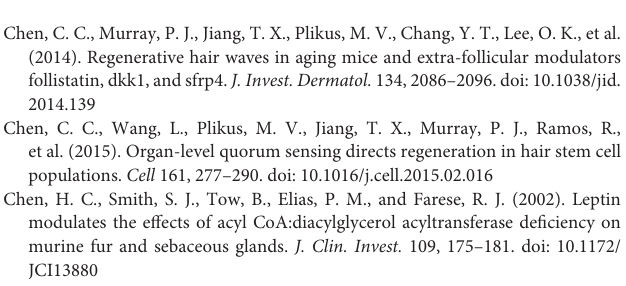
Supplementary Figure 2 | KEGG enrichment analysis respectively for upregulated and downregulated DEGs in YTD vs OTD and YAD vs